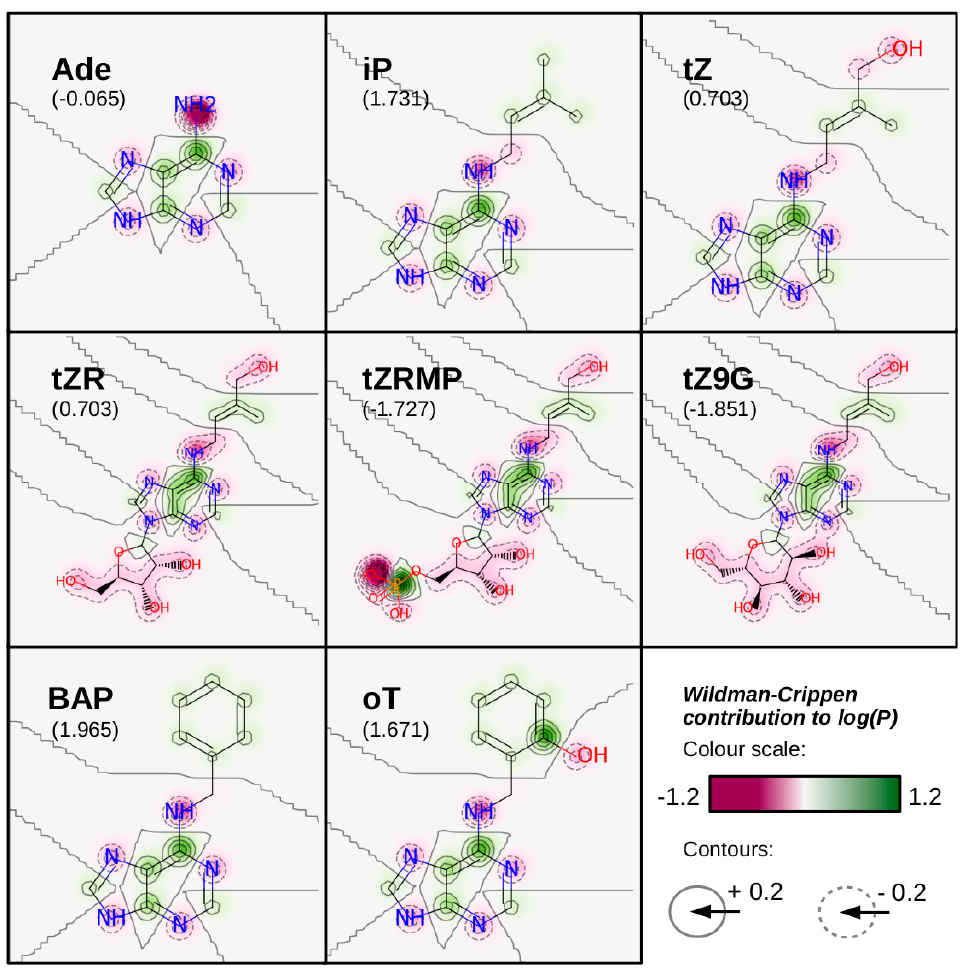
Figure 3. For selected CKs, Wildman-Crippen contributions of individual atoms to the value of log( P ) have been predicted according to [54]. Gaussian distribution of the contributions have been visualized and juxtaposed with the corresponding molecular structures. Negative contributions (which decrease the overall hydrophobicity of the molecule) are depicted in shades of pink, while positive contributions (which increase the overall hydrophobicity) are depicted in shades of green (refer to the colour-bar in the bottom right corner of the figure). Increments of Wildman-Crippen contribution levels are also expressed by solid (above zero levels) and dashed contours (below zero levels). For each molecule, the Wildman-Crippen value of log( P ) is given in the parentheses. Note that contributions of hydrogen atoms, which have been included in predicting total log( P ) values, are not shown. Calculation and visualization of the Wildman-Crippen contributions have been performed using RDKit: Open-source cheminformatics software (http://www.rdkit.org, accessed on 4 January 2021). Ade: adenine; iP: isopentenyl adenine; tZ: trans -zeatin; tZR: trans -zeatin riboside; tZRMP: trans -zeatin riboside monophosphate; tZ9G: trans -zeatin N 9 -glucoside; BAP: 6-benzylaminopurine; oT: ortho -topolin; P —octanol-water partition